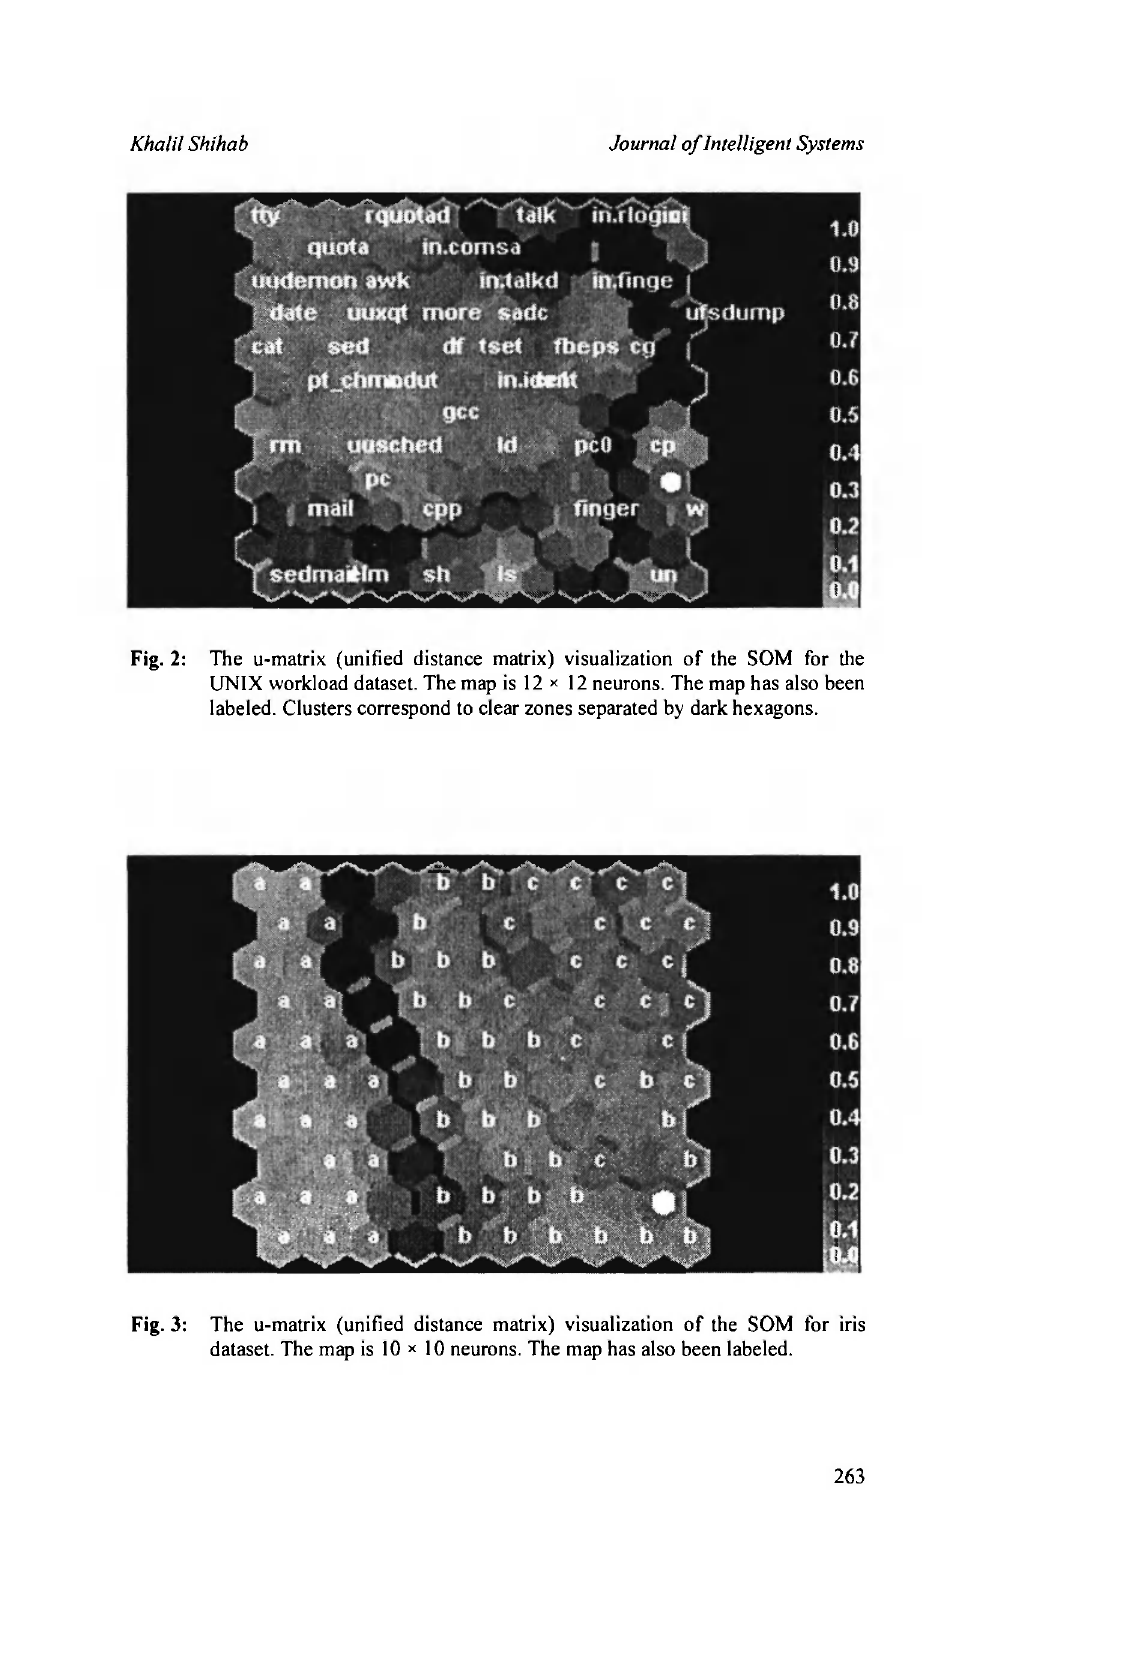
Fig. 3: The u-matrix (unified distance matrix) visualization of the SOM for iris dataset. The map is 10 χ 10 neurons. The map has also been labeled.